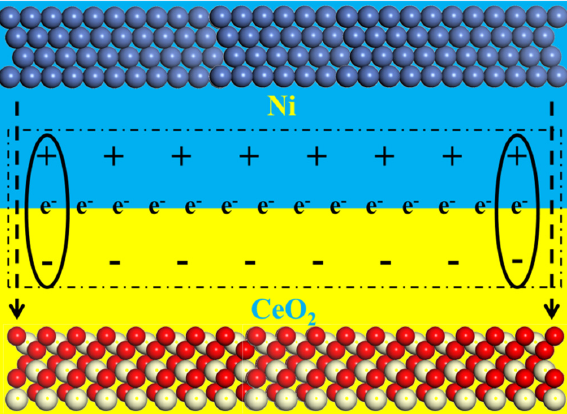
Figure 5. Schematic diagram of the interfacial electronic structure of Ni/CeO 2 HJ-NSs for HER in the alkaline solution.